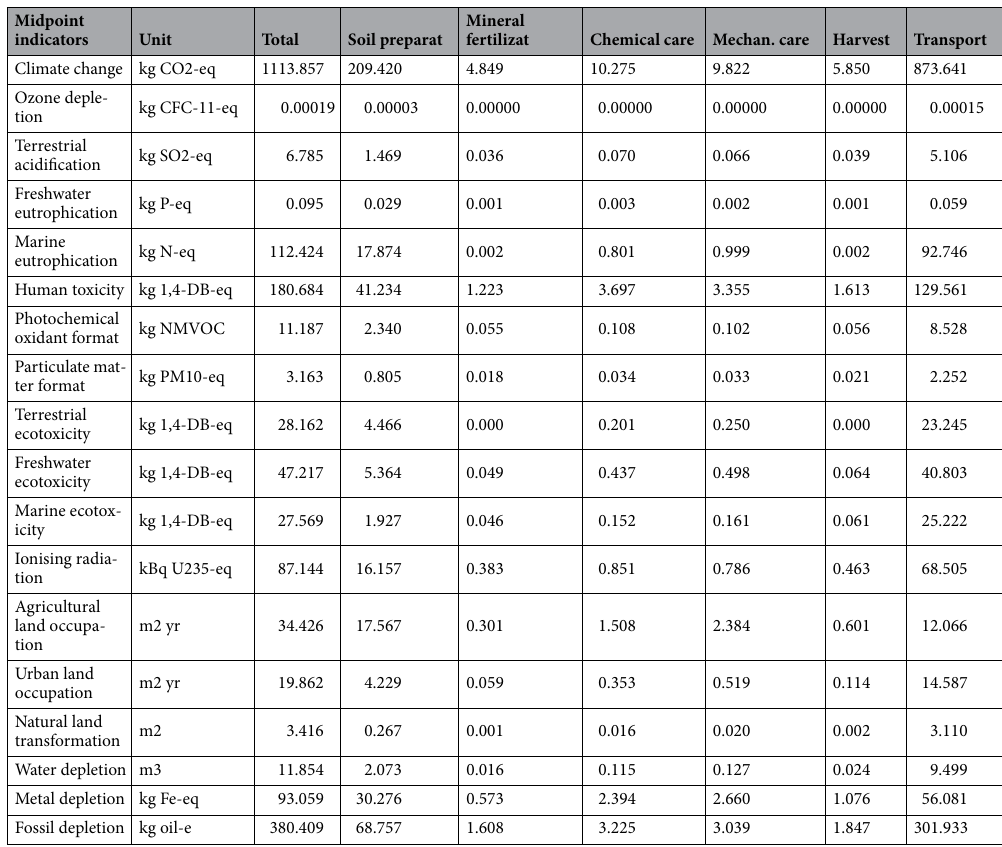
Table 7. Characterization factors of the ReCiPe Midpoint environmental analysis for the used technical means of production (processes).